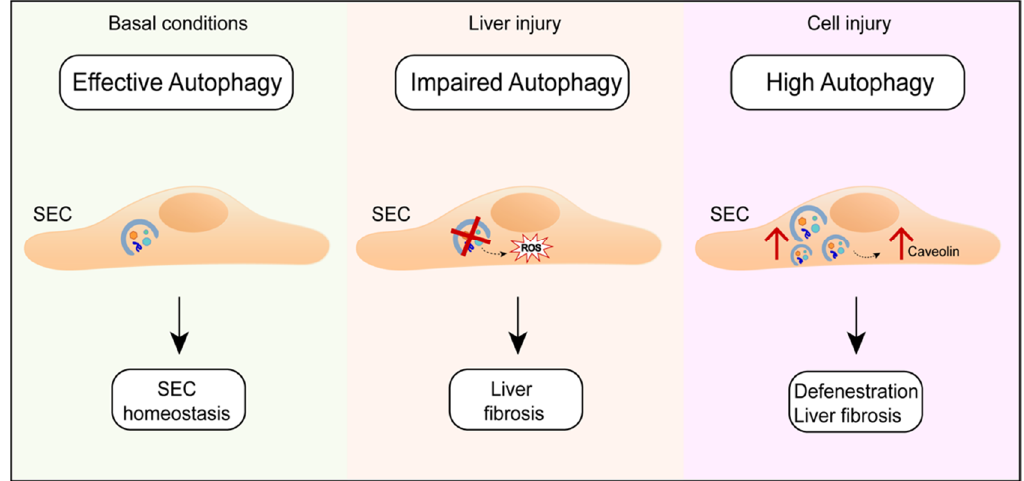
Figure 6. The role of autophagy in endothelial cells maintenance. Autophagy plays an important role in the regulation of the Sinusoidal endothelial liver cells (SEC) phenotype. In fact, under basal conditions, autophagy maintains SEC homeostasis. During liver injury, autophagy impairment increases oxidative stress and leads to liver fibrosis. On the other hand, a high autophagy rate induces caveolin-1 degradation, thus leading to SEC defenestration and liver fibrosis.